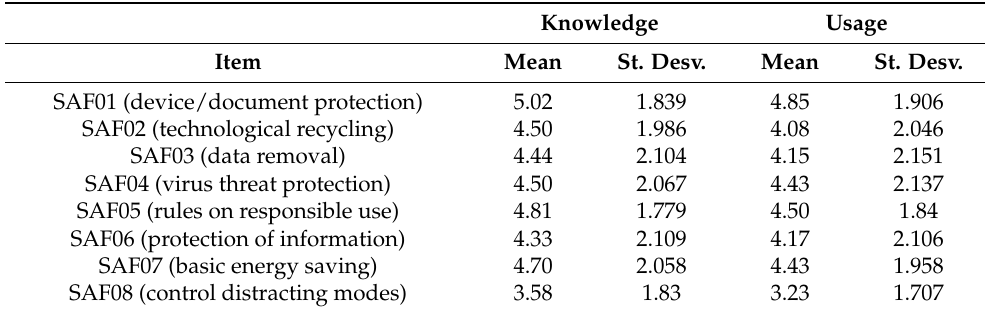
Table 9. Tools associated with safety